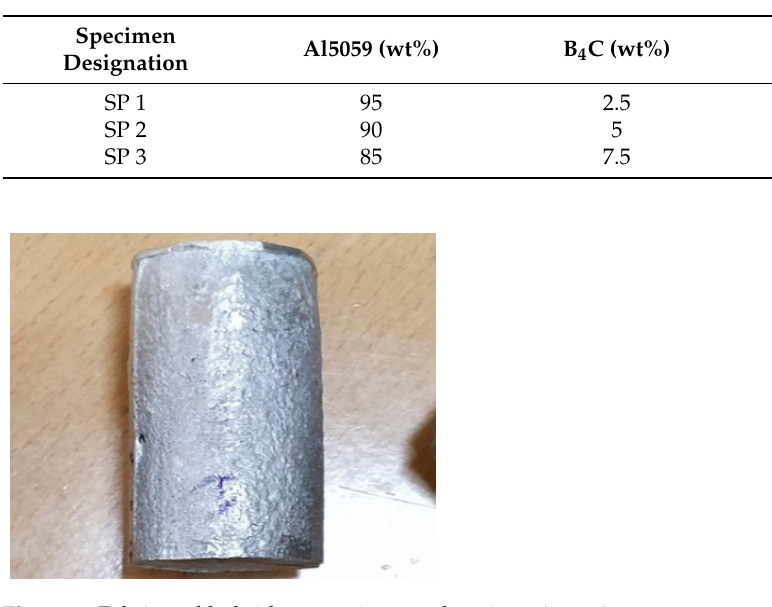
Table 2. wt% of the composite materials in each specimen.